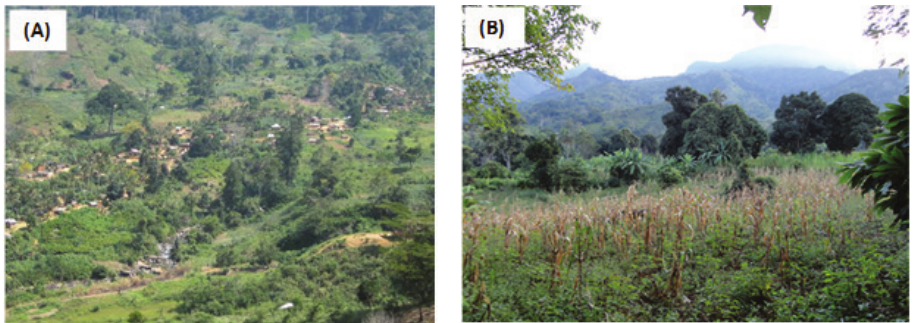
Figure 5. Drivers to fragmentation, note the settlements in the valley and cleared forest in the back- ground and fore ground for crop farming and grazing, respectively ( A ) and small scale maize and banana fields within the forest in ( B